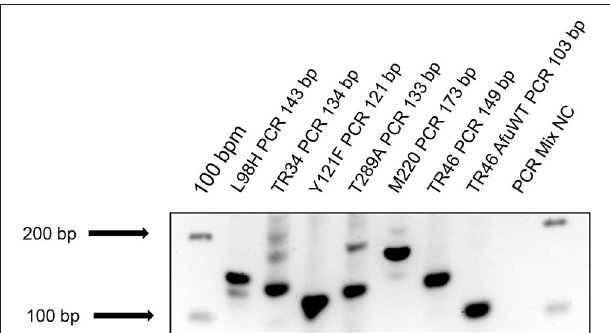
FIGURE 1 | Agarose gel electrophoresis of the six established in-houes ARAf PCR assays. L98H, TR34, Y121F, T289A, and M220 PCRs were performed using DNA (mixture of human and fungal DNA) of a TR34/L98H mutation positive BAL sample of a patient suffering from AML (Hamprecht et al., 2012). The TR46 PCR was performed using a TR46 positive clinical A. fumigatus isolate (lane 7) and A. fumigatus wildtype (WT) DNA (lane 8). NC, negative control, bpm, base pair